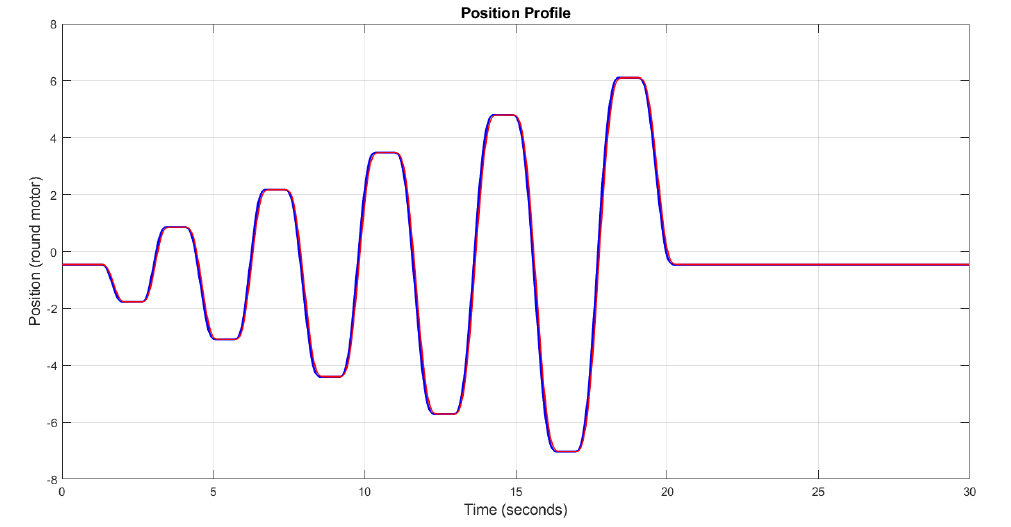
Figure 19. Experimental Position Profile (red line); Reference Position Profile (blue line).